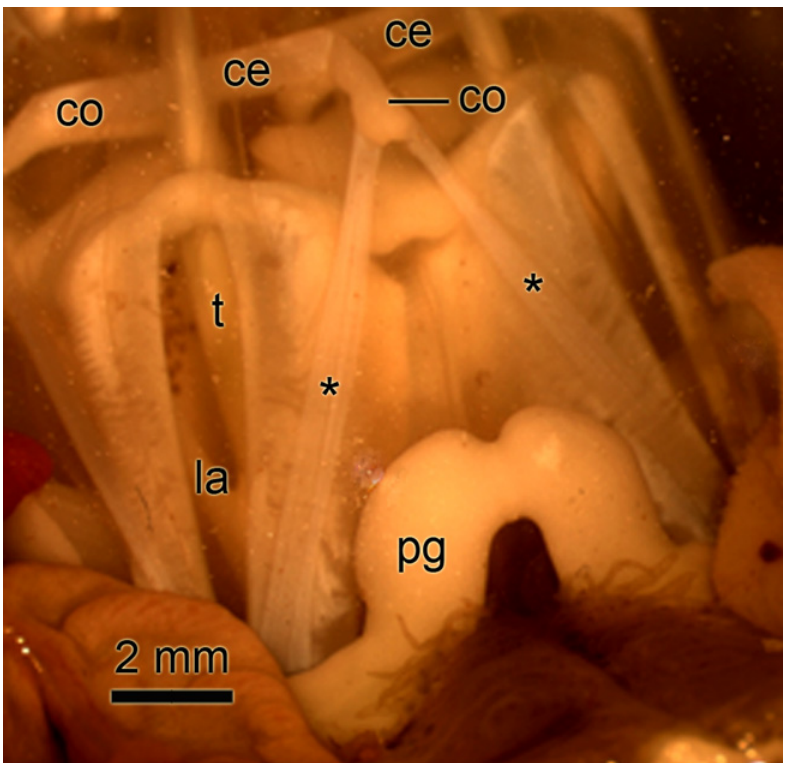
Fig 1. Photograph of the lantern of Paracentrotus lividus . The view is from the side and slightly above the lantern. Two of the five segments of the lantern (la) are visible. The compasses (co) are partly elevated due to contraction of the compass elevator muscles (ce). Asterisks, compass depressors; pg, perignathic girdle (edge of test); t,